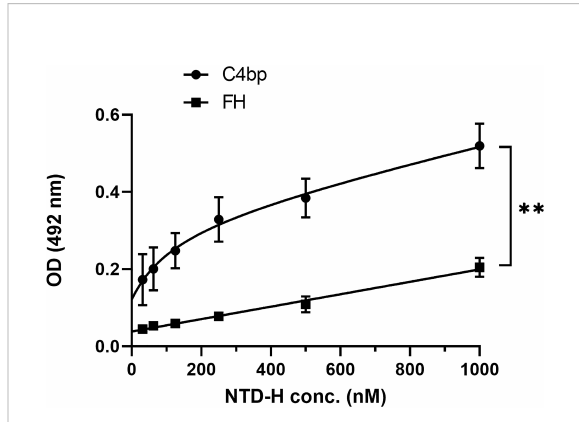
FIGURE 4 A dose response analysis of NTD-H binding to C4bp and to the alternative pathway regulator FH. The binding experiment was done by ELISA. Comparison between the two data sets was analyzed by the t test. p < 0.01 = **.